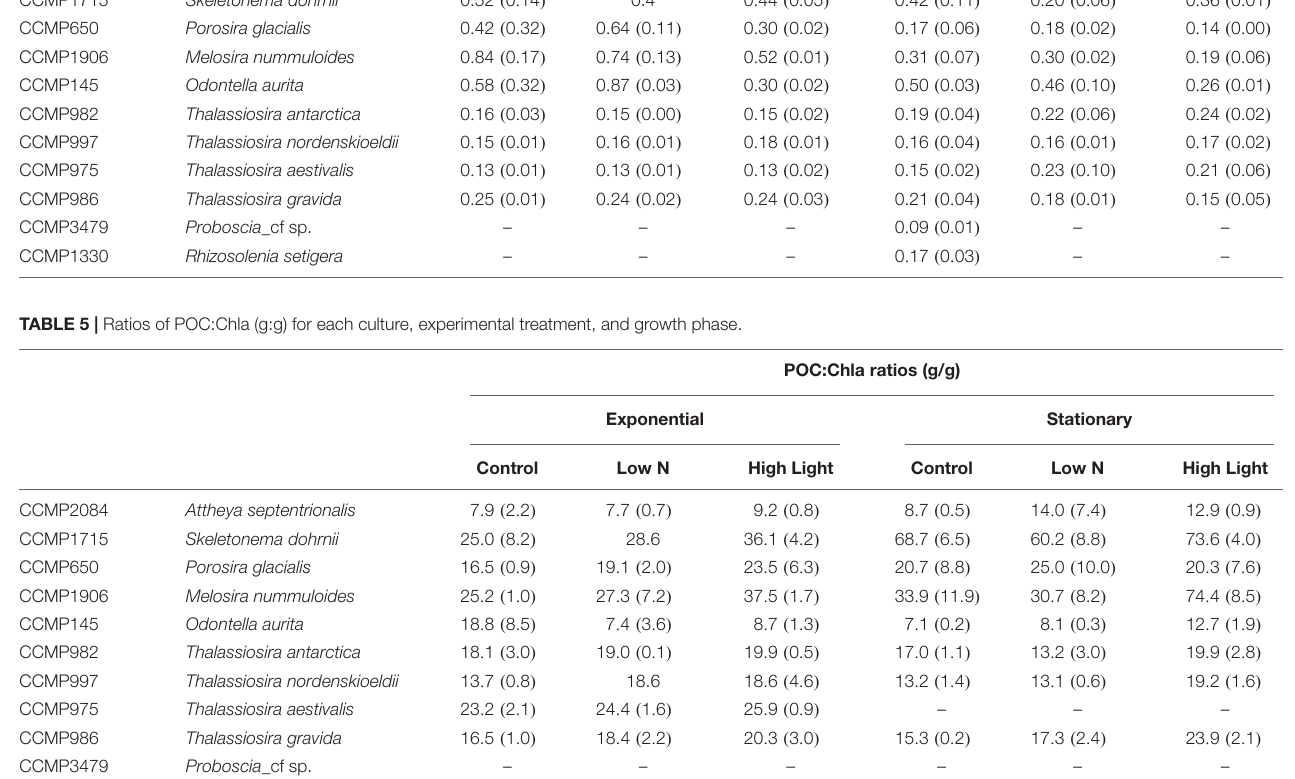
TABLE 4 | Ratios of BSi:POC (mol:mol) for each culture, experimental treatment, and growth phase. BSi:POC ratios (mol:mol) Exponential Stationary Control Low N High Light